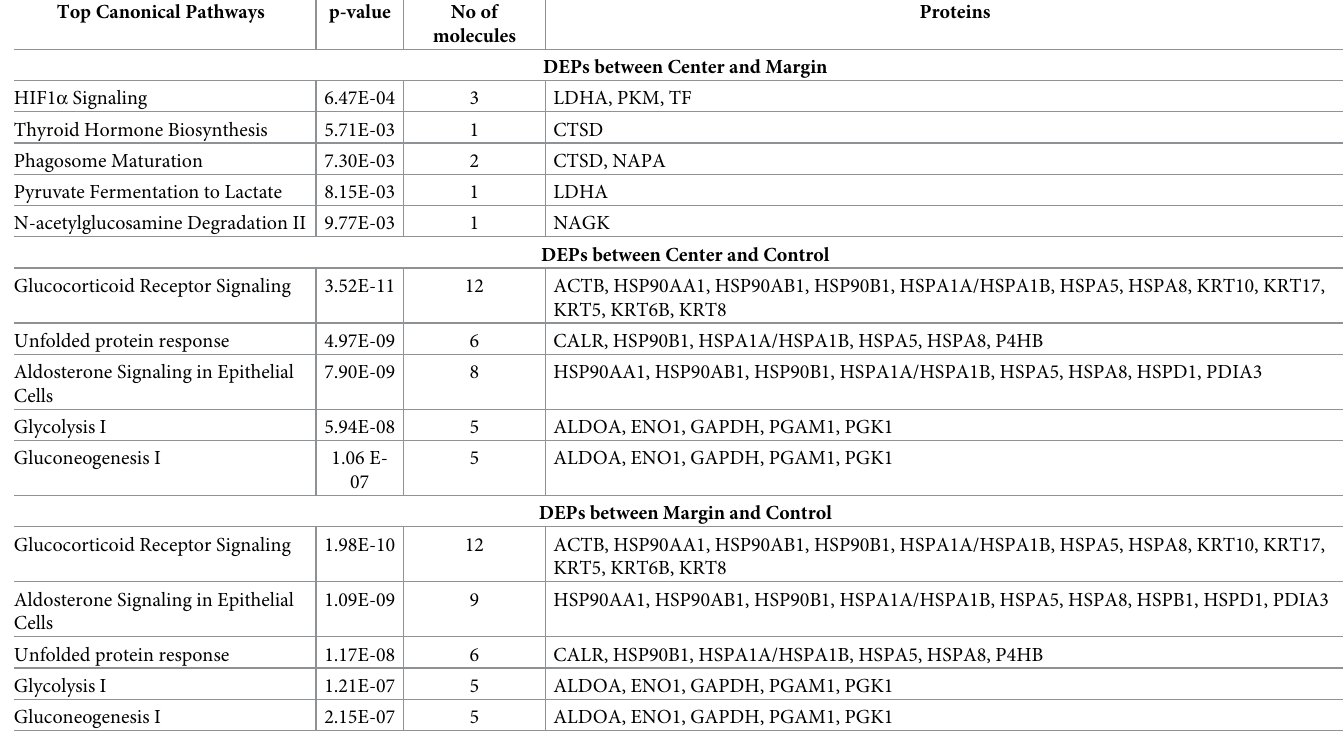
Table 2. Top canonical pathways of differentially expressed proteins (DEPs) in SCC tumor. Top Canonical